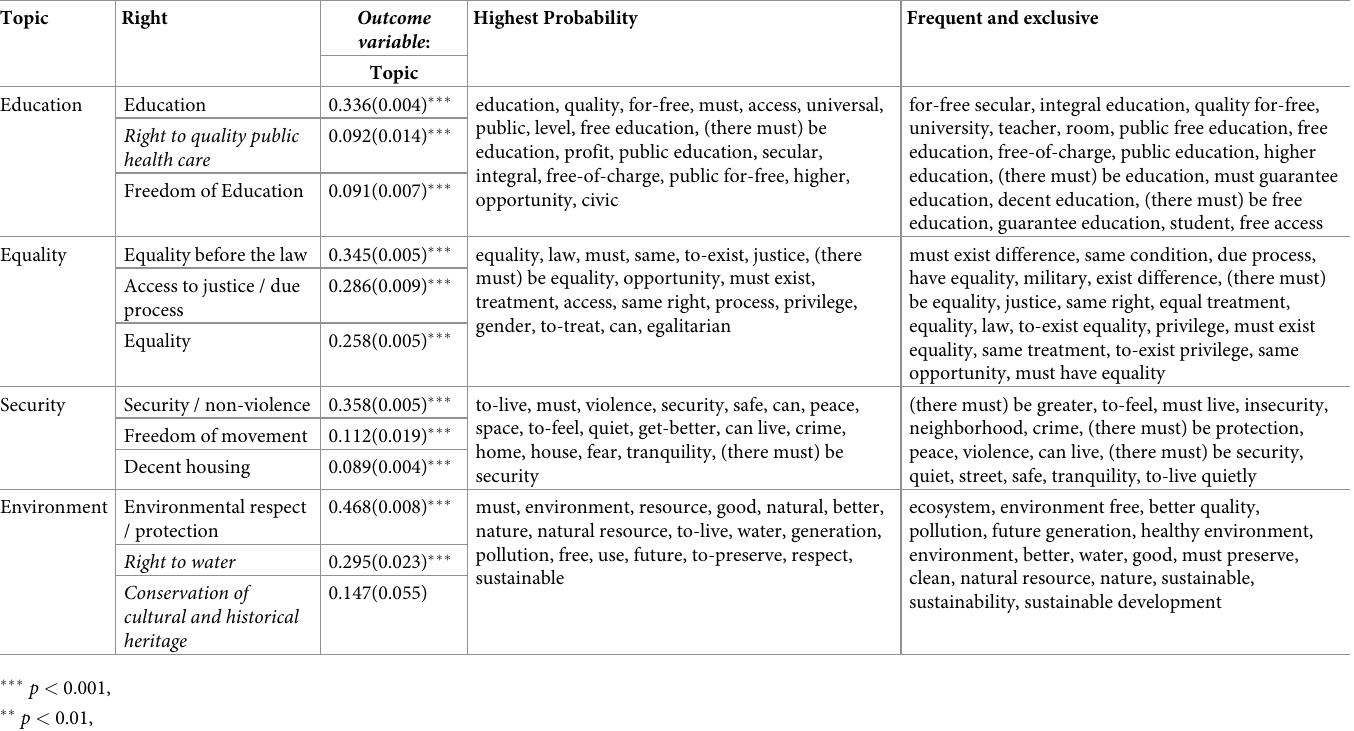
Table 3. OLS regressions results for STM. Table shows the top three categories for each regression. Concepts in italic font were not included in the original list of concepts proposed by the government, and were added by ELAs participants. The last two columns in the table show the word sets for three topics. The words shown here have been translated into English. All the STM analysis has been performed with the original texts in